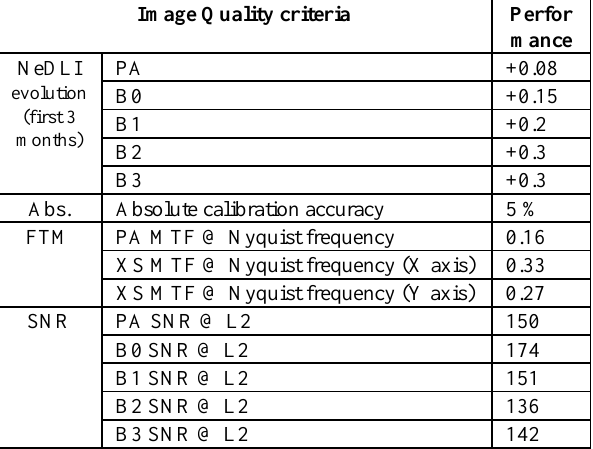
Table 5. Main Image Quality performance. Preliminary results (assessed April 5,